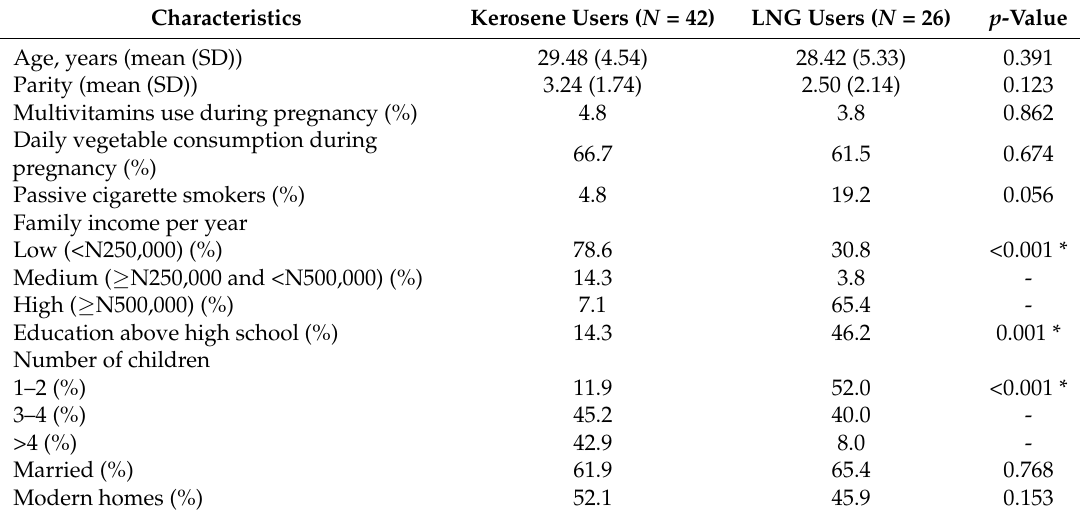
Table 1. Characteristics of study population by cooking fuel group.